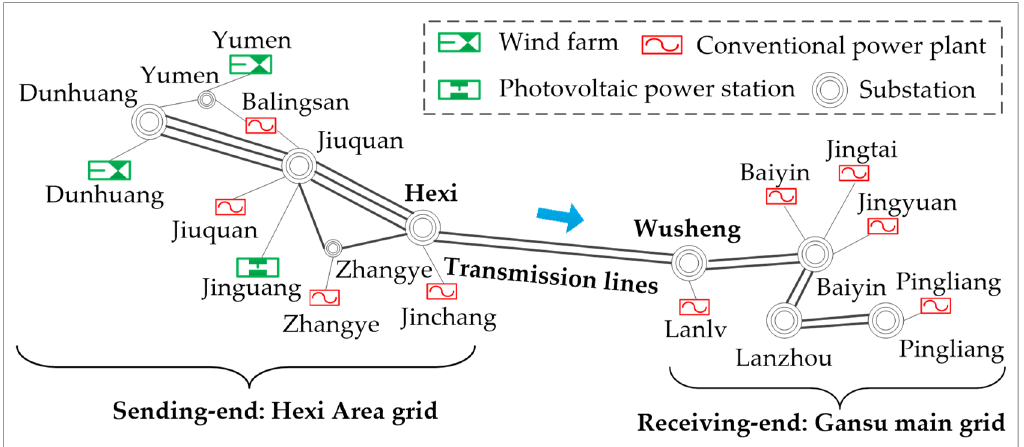
Figure 5. Schematic diagram of the Gansu Province Power Grid.